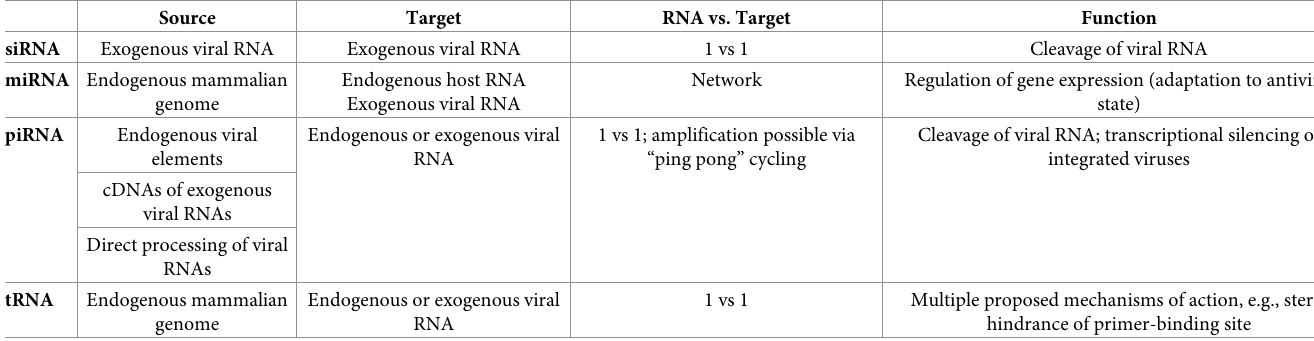
Table 1. Classification of antiviral small